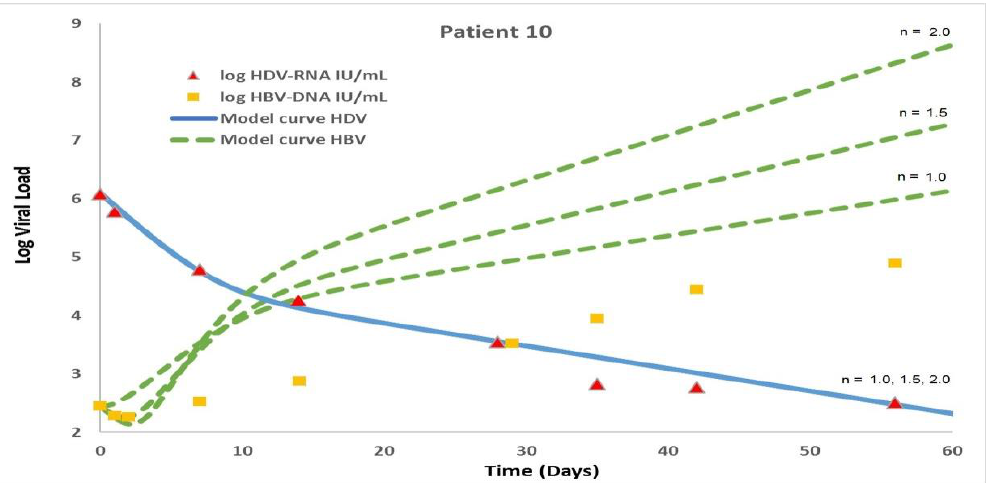
Figure 1. The model Equations (1) and (2) failed to reproduce HBV kinetics in additional patients reported in Yurdaydin et al. [5]. Model parameter values were D 0 = 1.2 × 10 6 , B 0 = 282, c = 0.51, g = 0.089, ε = 0.97.